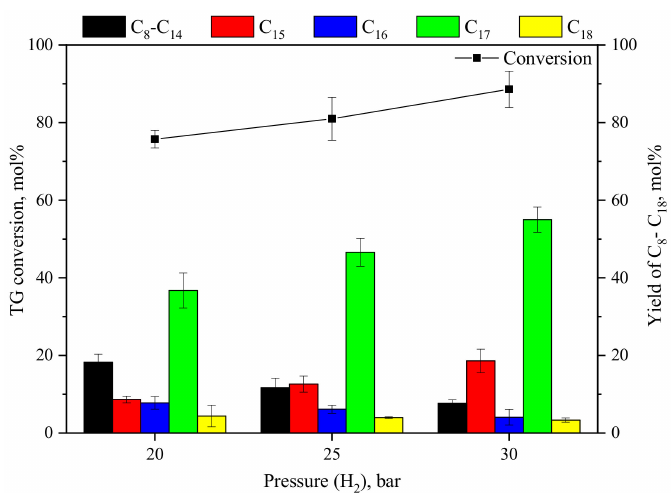
Figure 4. Conversion of triglycerides and yield of C 8 –C 18 products under di ff erent H 2 pressures.